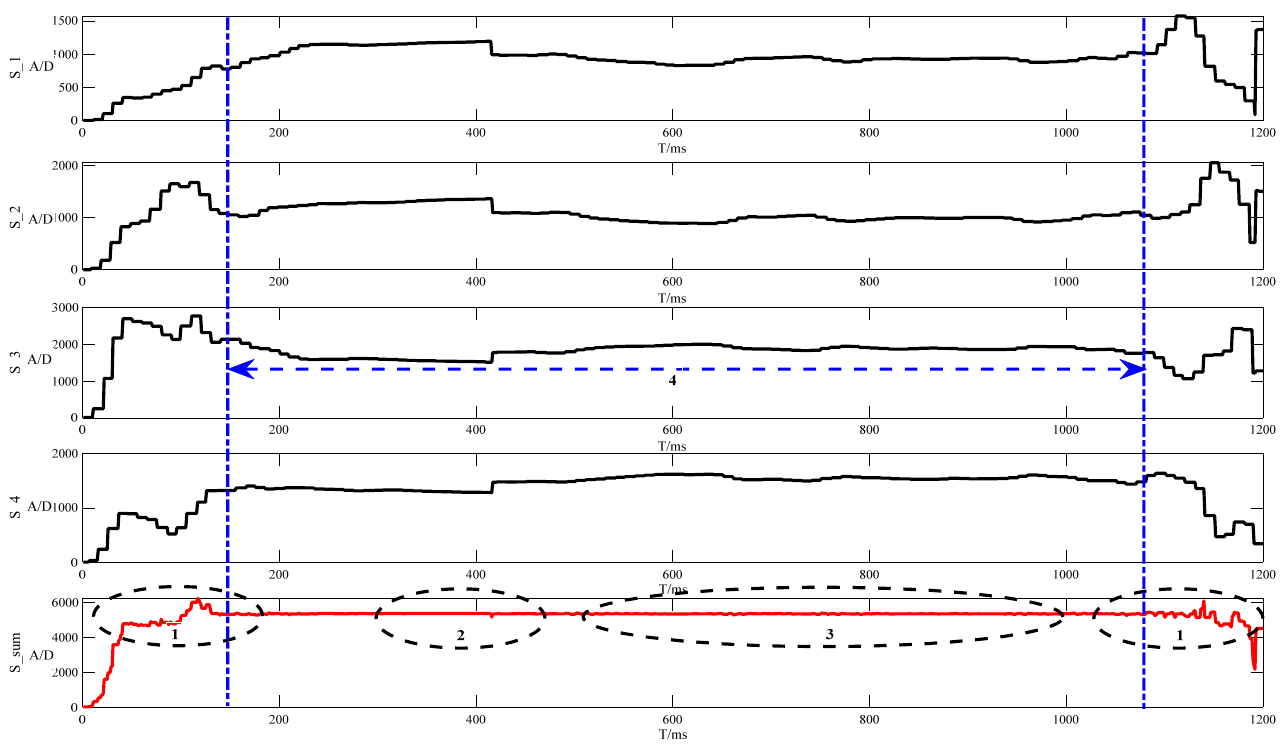
Figure 5. Test hardware structure.